Question: Express in one sentence what the figure is showing.
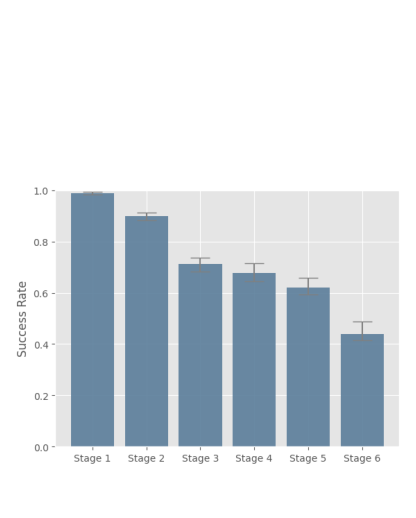
Answer: Success rates for open ended exploration on 6 stages and 4000 timesteps